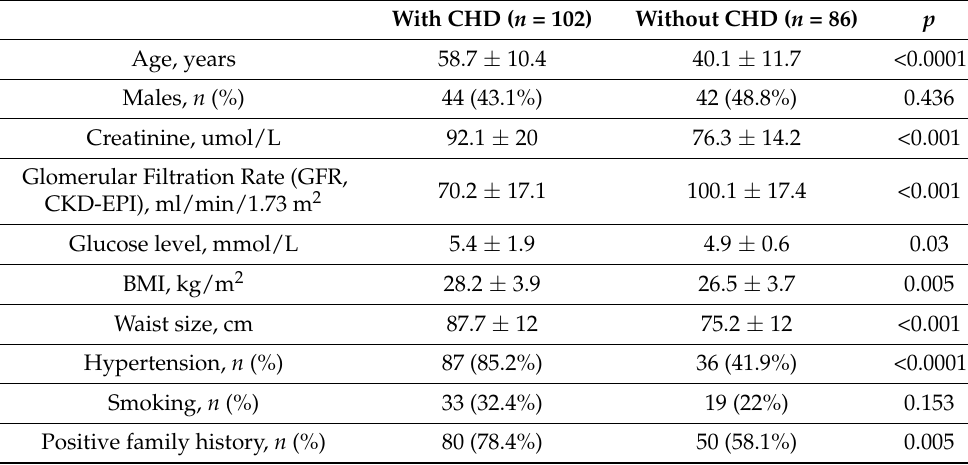
Table 1. Non-lipid risk factors and CHD development in FH patients.